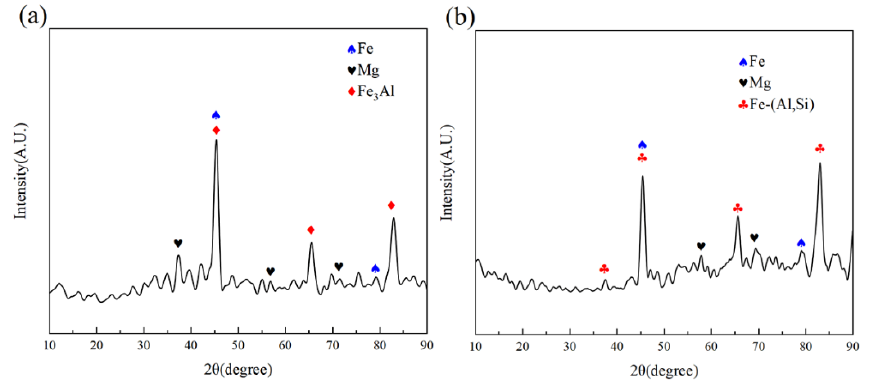
Figure 7. micro-XRD patterns of the reactive layer with different Si contents: ( a ) Cu − 0%Si and ( b ) Cu − 5%Si.